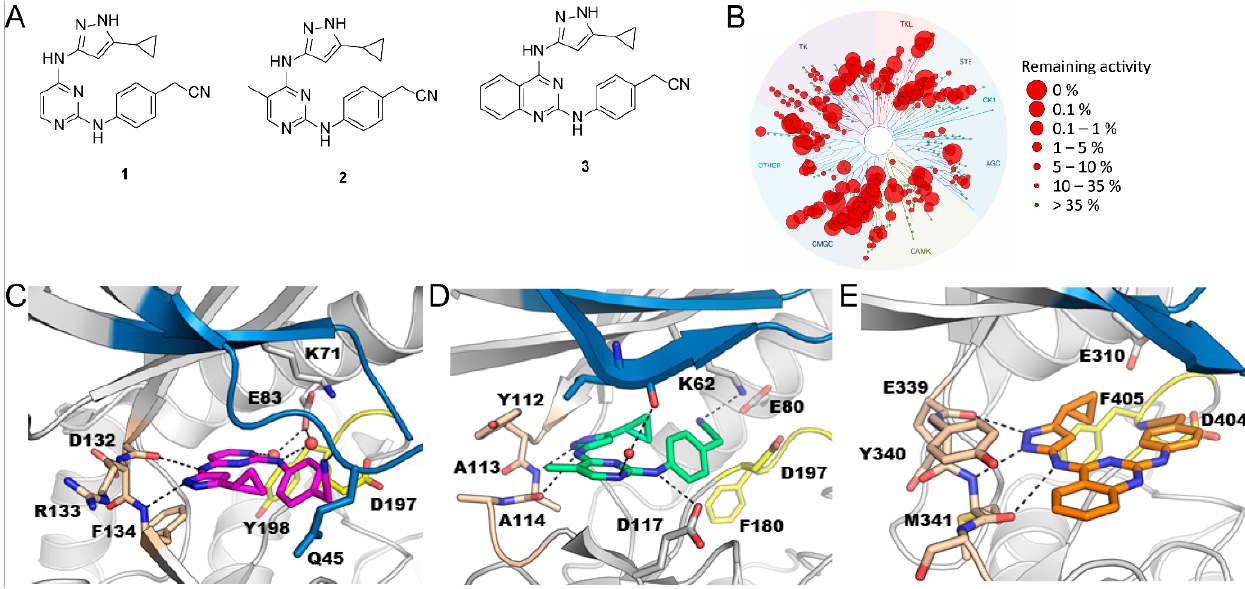
Figure 2. ( A ). Chemical structures of three previous published promiscuous kinase inhibitors 1 , 2 and 3 . ( B ). Selectivity profile of 1 against 359 recombinant human protein kinases at a screening concentration of 1 µM, using the KINOMEscan assay platform [41]. ( C ). Crystal structure of VRK1 in complex with 1 (PDB: 3OP5). ( D ). Crystal structure of STK17B in complex with 2 (PDB: 3LM0). ( E ). Crystal structure of c-Src in complex with 3 (PDB: 3F6X). The hinge region is highlighted in beige, the P-loop in blue, and the DFG motif (in VRK1 DYG motif) in yellow.